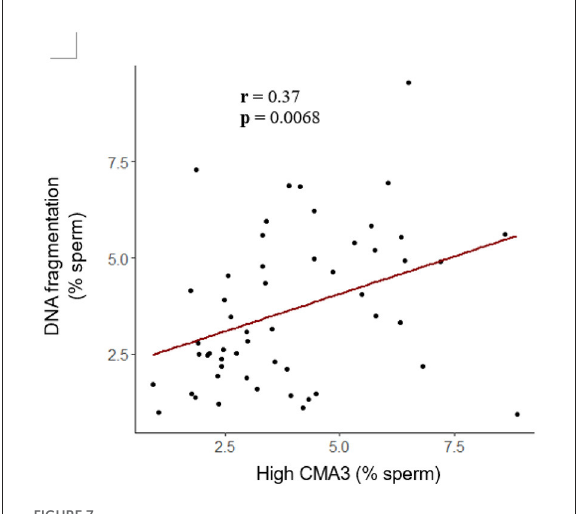
FIGURE7 Correlation between the percentage of spermatozoa from bulls with protamine deficiency (high CMA3) and DNA fragmentation. Based on these data, as the percentage of spermatozoa with protamine deficiency increased, so too did the incidence of DNA fragmentation ( r = 0.37; p < 0.01; Pearson’s product-moment correlation). Each dot represents an individual ejaculate from a bull of HF ( n = 9) and LF ( n =